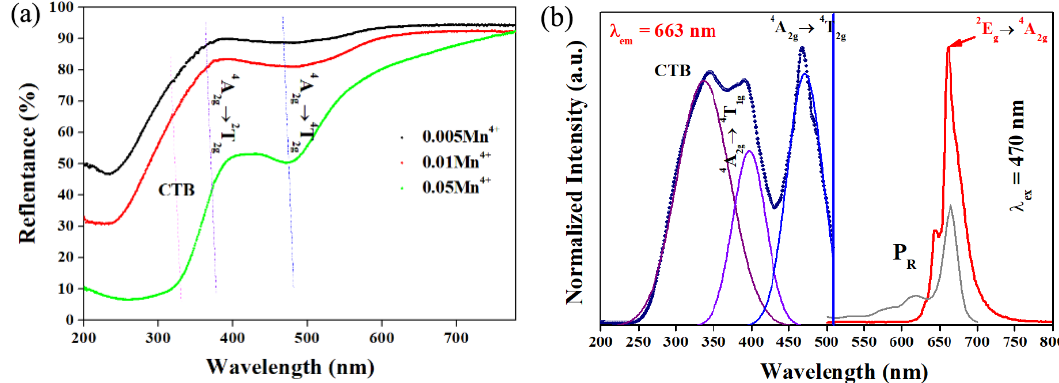
Figure 6. ( a ) The diffuse reflection (DR) spectra of LMA/xMn 4+ (x = 0.005, 0.01, and 0.05); ( b ) photoluminescence (PL) and PL excitation (PLE) spectra of LMA/0.01Mn 4+ at room temperature and the absorption spectrum of phytochrome P R (P R is defined as the red light absorbed by the phytochrome).